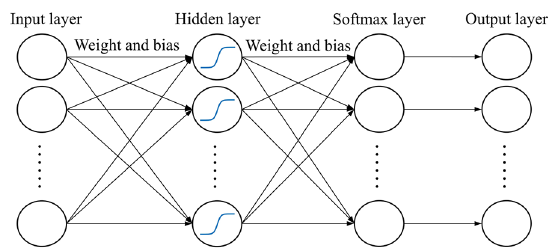
Figure 15 The structure of the pattern recognition network